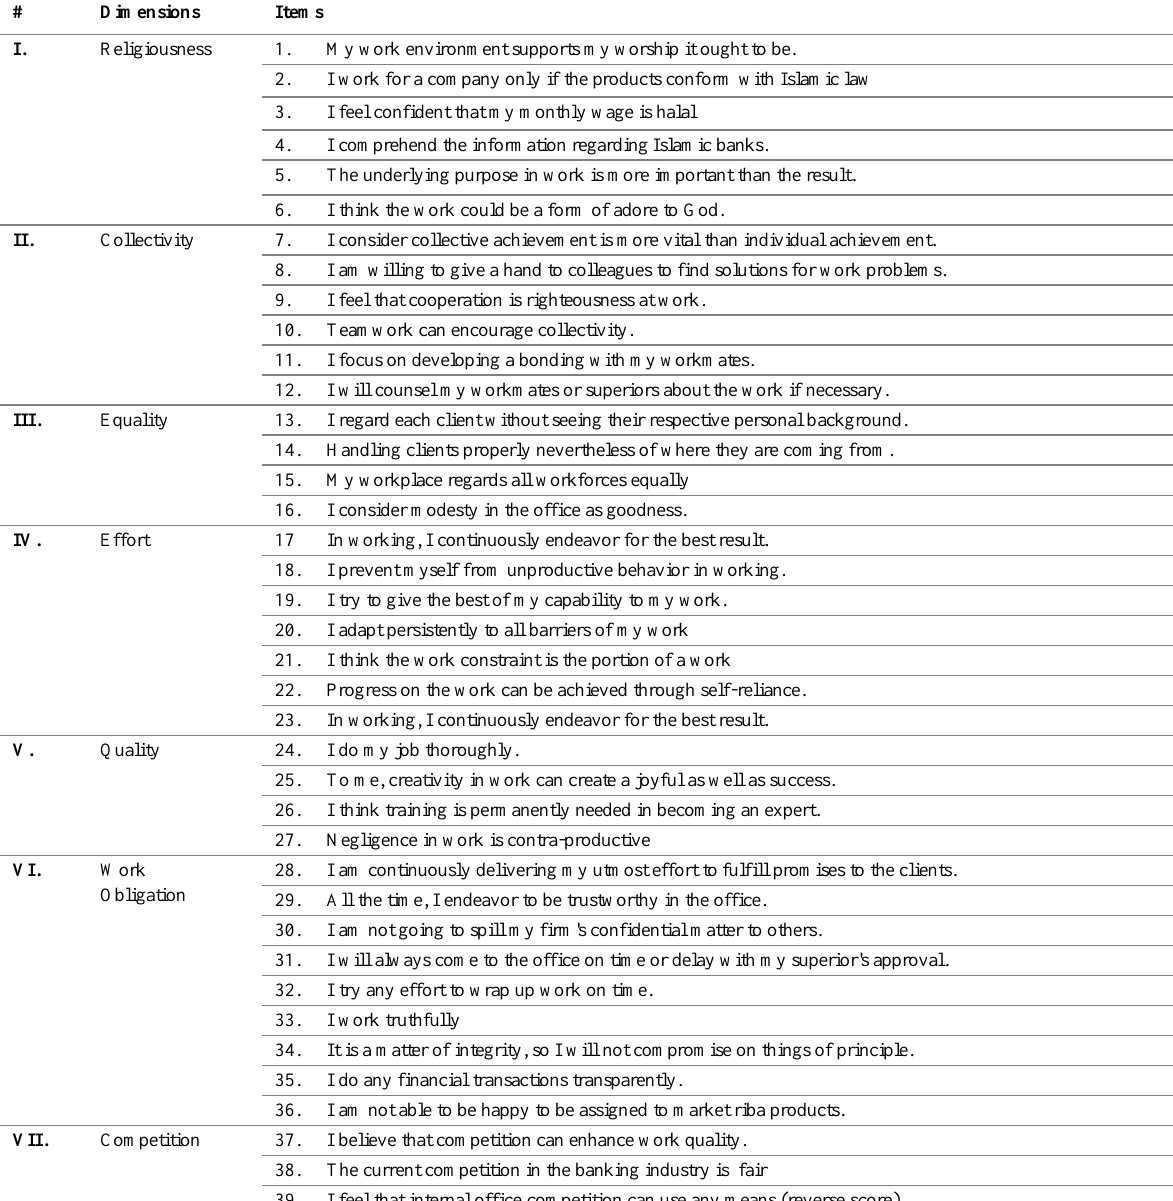
Table 1: The Measurement of Islamic Work